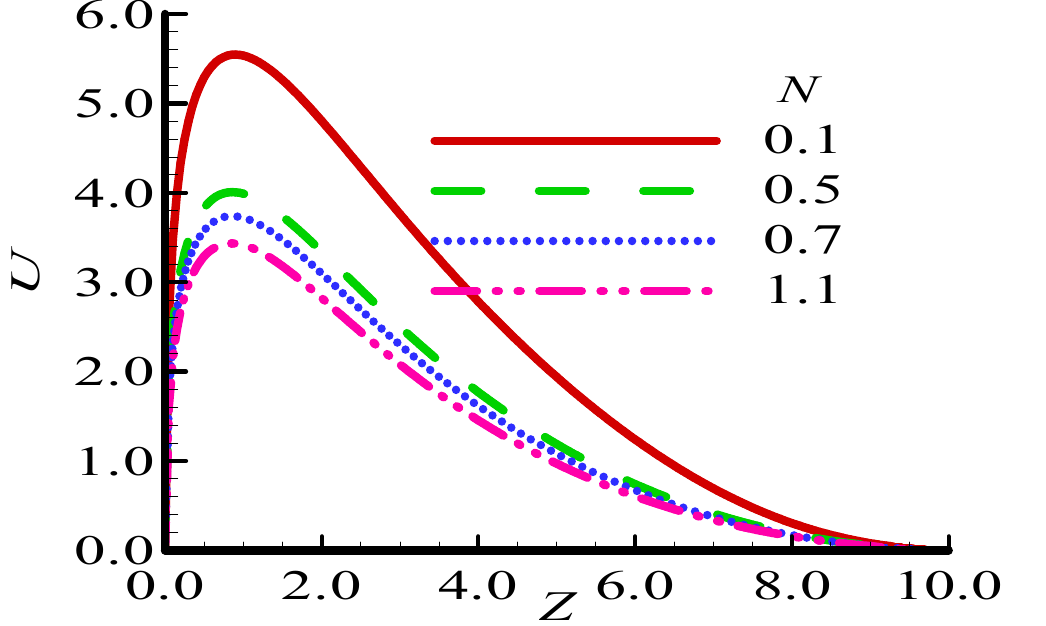
Figure 12. Outcomes of radiation parameter 𝑁 on velocity distribution 𝑈 , when 𝑁𝑏 = 1.5,𝑁𝑡 = 1.5,𝑃𝑟 = 7.0 , and 𝑆𝑐 = 10.0 .